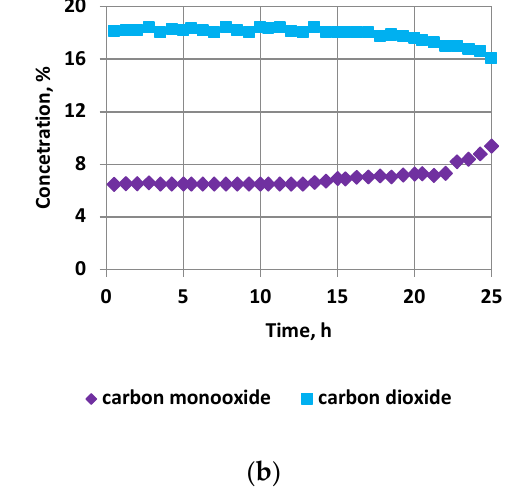
Figure 9. Stability performance of the catalyst. Power—25 W. Temperature—450 °C. ( a ) Ethanol conversion and hydrogen production; ( b ) CO and CO 2 concentration.